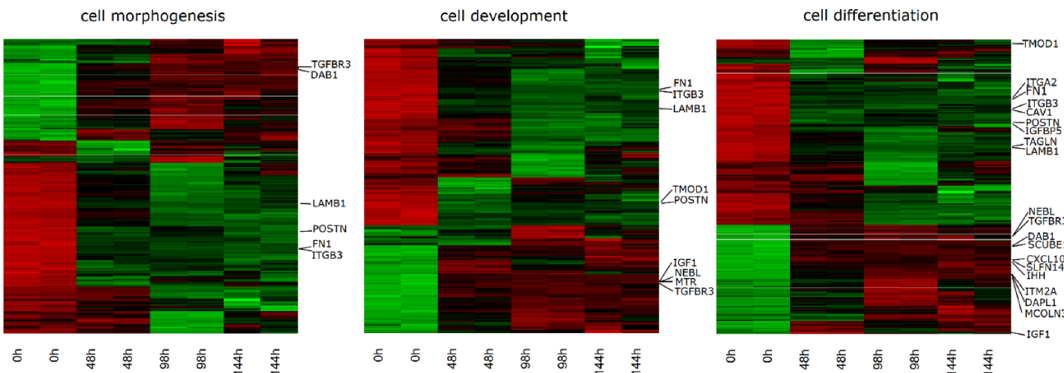
Figure 1. Heat map representation of di ff erentially expressed genes belonging to the chosen “cell development”, “cell di ff erentiation" and "cell morphogenesis” gene ontology (GO) BP terms. Arbitrary signal intensity acquired from microarray analysis is represented by colors (green, higher; red, lower expression). Log2 signal intensity values for any single gene were resized to Row z-score scale (from − 2, the lowest expression to + 2, the highest expression for a single gene). Due to the large number of genes on the heatmap, only the genes chosen for analysis in the manuscript were marked, with their names indicated.